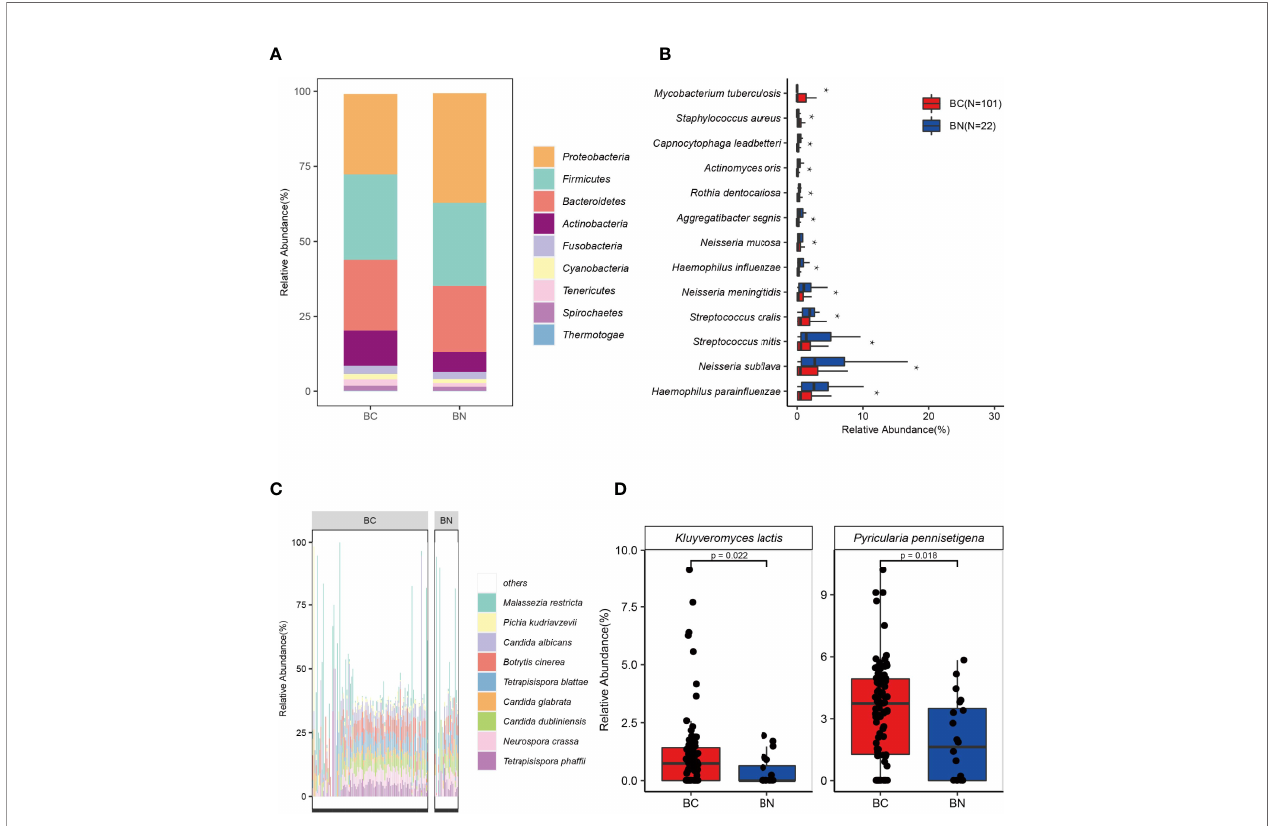
FIGURE 2 | The lung microbial signature differed between BC and BN patients. Stacked bar chart indicates that the distribution of bacteria in the BC and BN (A) . Proteobacteria , Firmicutes , and Bacteroidetes were the three most abundant phyla among TB patients (A) . Bacteria that were signi fi cantly enriched in BC or BN were identi fi ed using LEfSe, of which those with the highest relative abundance were shown in (B) . Tetrapisispora blattae , Candida albicans , Malassezia restricta , Tetrapisispora phaf fi i , Neurospora crass , and Botrytis cinerea were the most abundant fungal species in TB patients (C) . Two fungal species were signi fi cantly enriched in the BC patients (D) * represents p value <